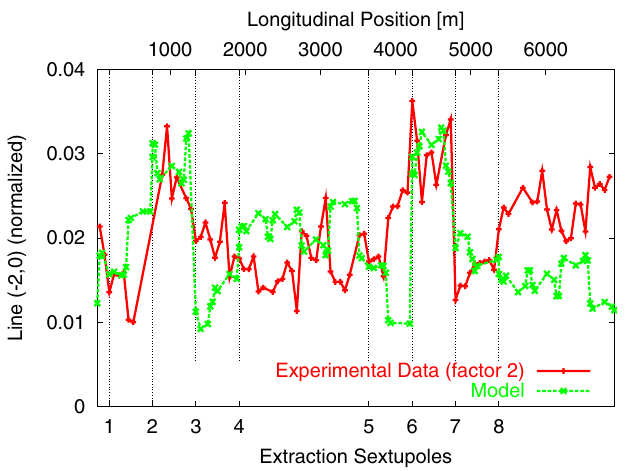
FIG. 12. (Color) Longitudinal variation of the spectral line (cid:2)(cid:1) 2 ; 0 (cid:3) from experiment and from the nominal